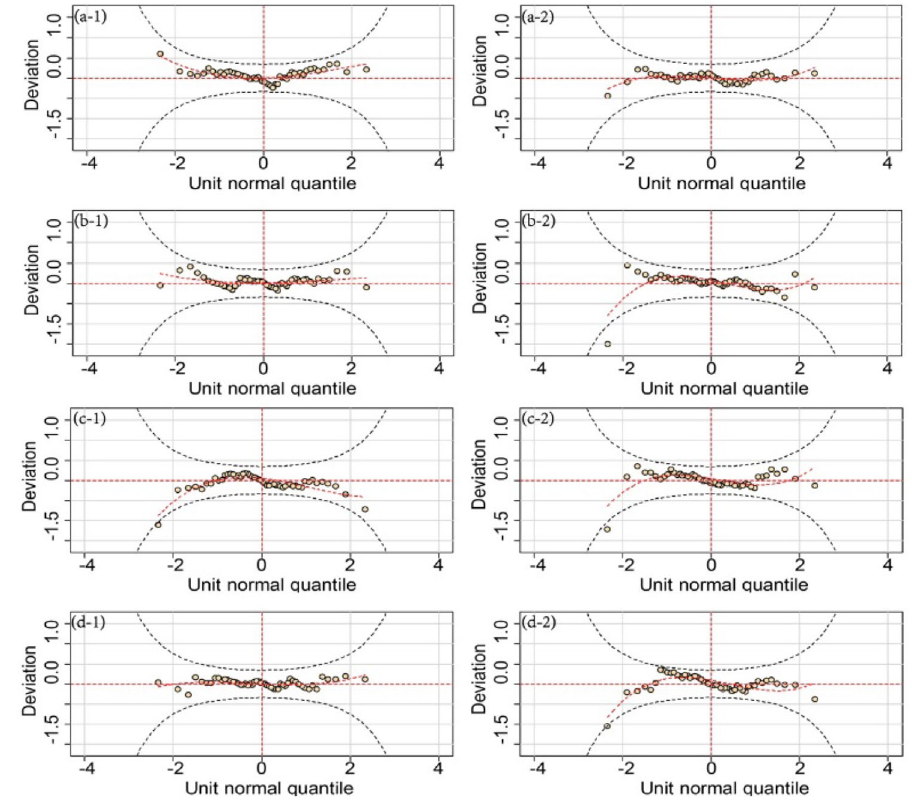
Fig. 7 The worm plot for the simulation of spring precipitation by the seasonal model (left) and the global model (right) at four selected stations (Xunwu ( a -1, a -2), Dongyuan ( b -1, b -2), Lingxia ( c -1, c -2), and Shenzhen ( d -1, d -2)) in the East River basin in southeastern China. The two black dashed lines denote